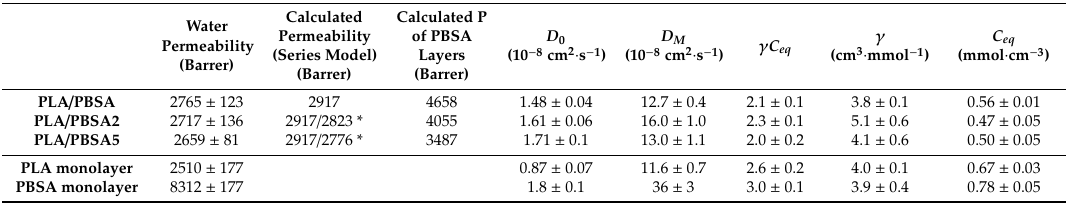
Table 7. Water permeation parameters for the PLA / PBSA, PLA / PBSA2 and PLA / PBSA5 multilayer films. Experimental and predicted